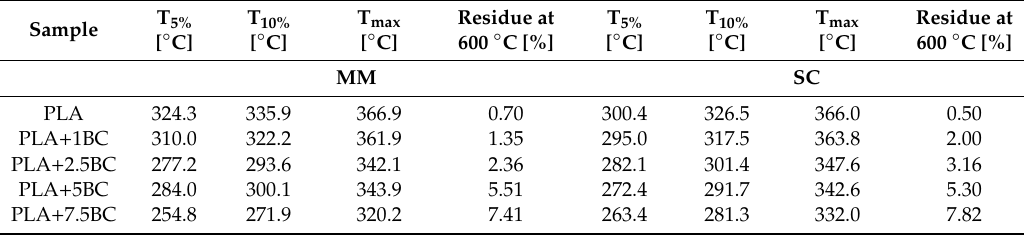
Table 3. Elemental composition of used BC.